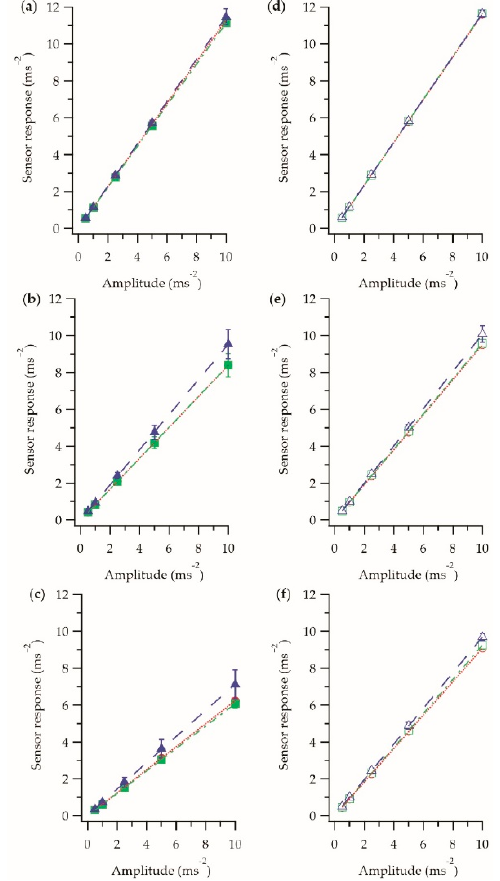
Figure 5. Sensor response of the E-yarns at different stages in the manufacturing process at three different frequencies. ( a – c ) Amplitude response in the z -axis at 80 Hz, 800 Hz and 1250 Hz respectively. Soldered stage ; encapsulated stage ; the final E-yarn . ( d – f ) Amplitude response in the x-axis at 80 Hz, 800 Hz and 1250 Hz respectively. Soldered stage ; encapsulated stage ; the final E-yarn . Each data point is an averaged measurement taken using four E-yarns, with the error bars representing the standard deviation in the measurements. Details of the linear fittings (dashed lines) are shown in Table 2. The results for the final E-yarn has previously been presented elsewhere [1]. Table 2. Fitting parameters for the amplitude response of the accelerometer at the different stages of the E-yarn manufacturing process. S is the sensor response, a is the amplitude.